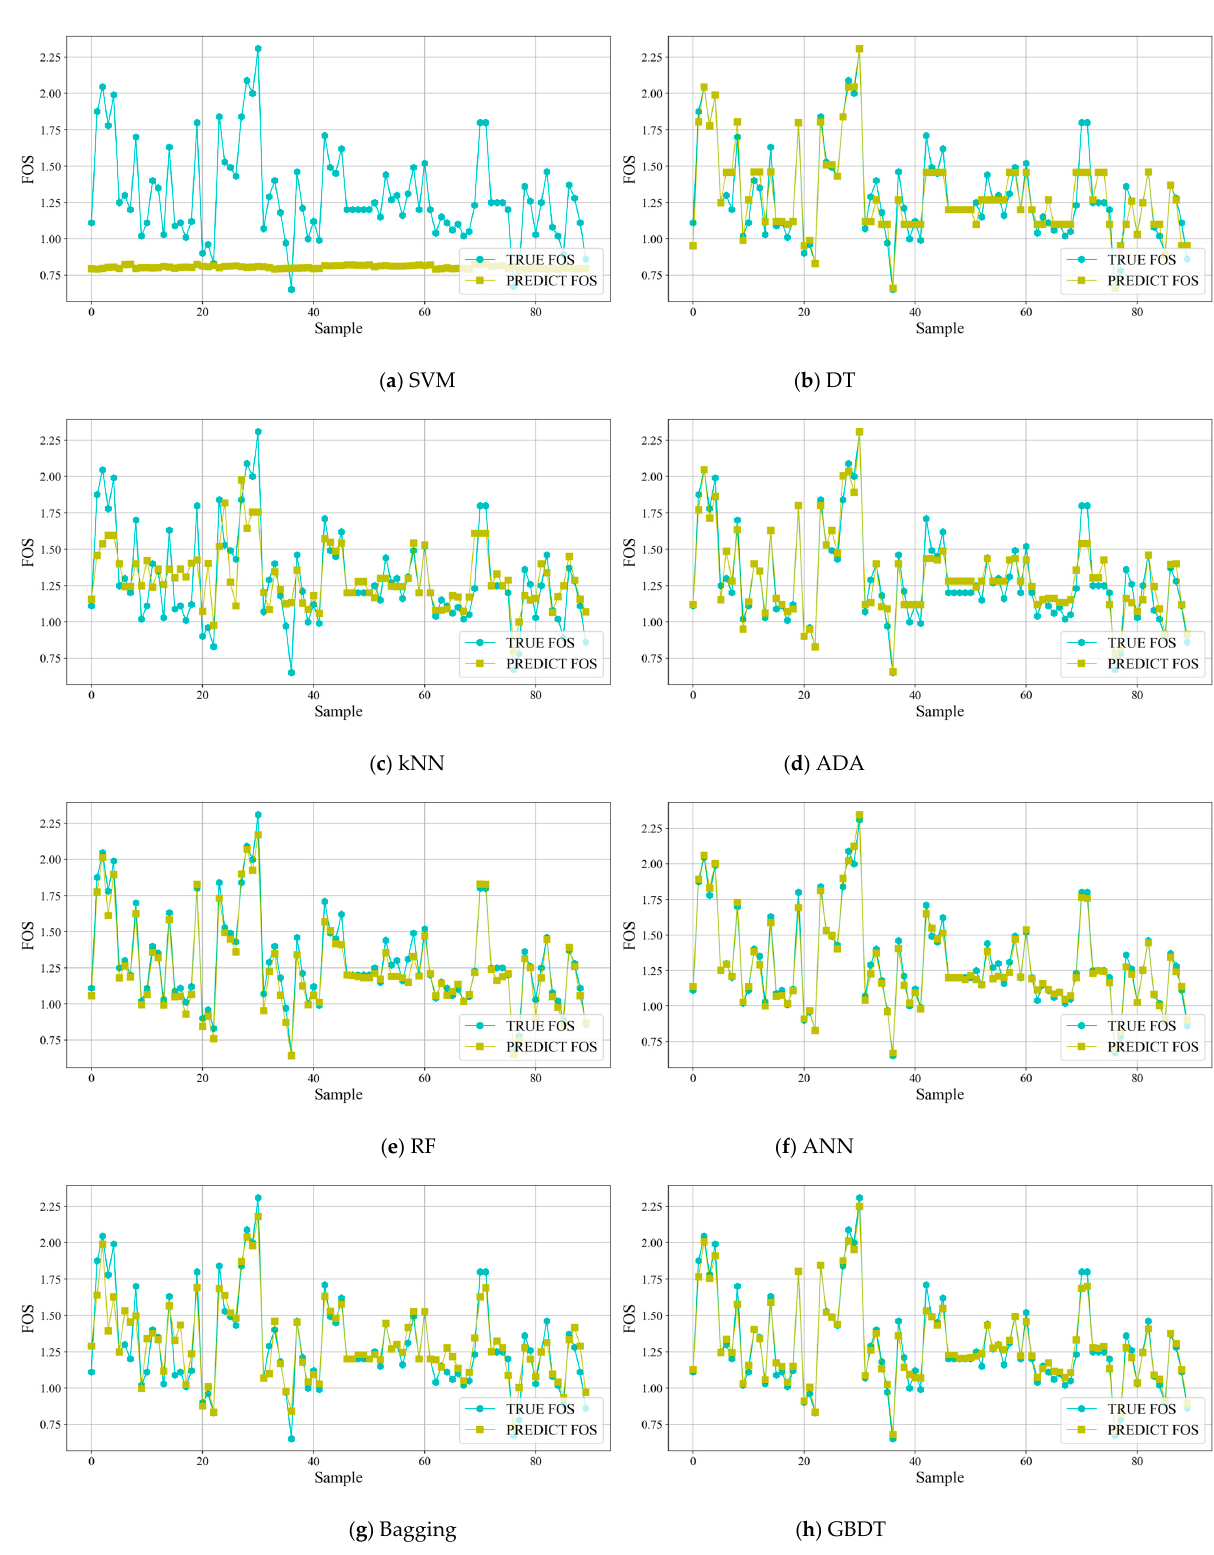
Figure 3. Results of the eight machine learning methods on training set.